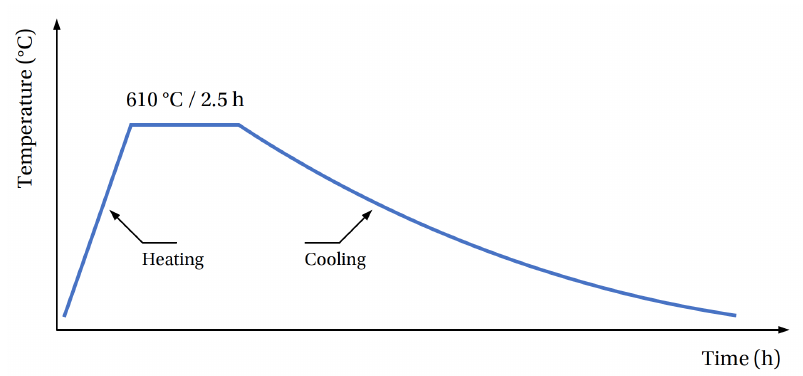
Figure 2. Heat treatment for annihilating initial residual stresses before drilling.